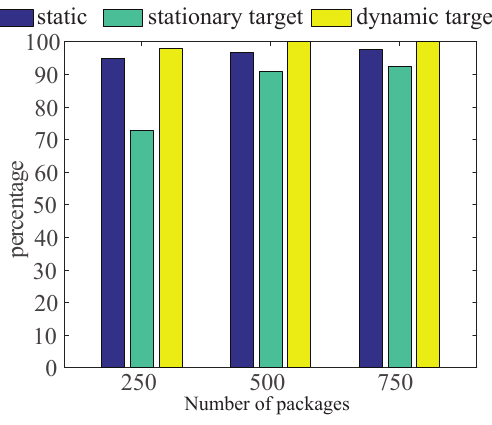
Figure 9. Detection rate of different data